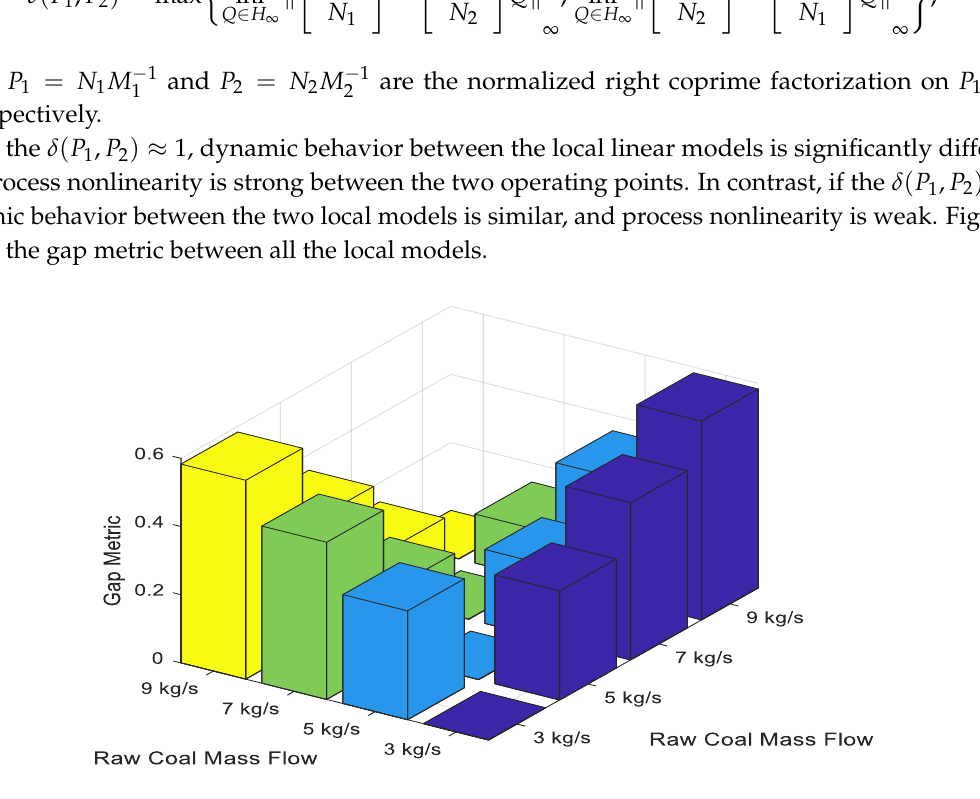
Figure 6. Gap metric between local linear models.